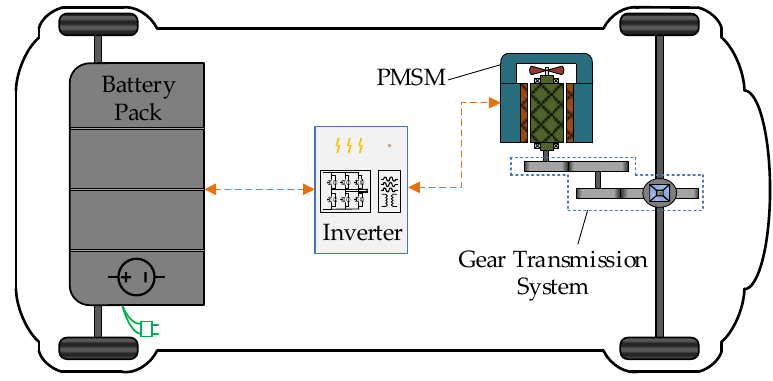
Figure 1. Schematic of the structure of an electric vehicle drive system.